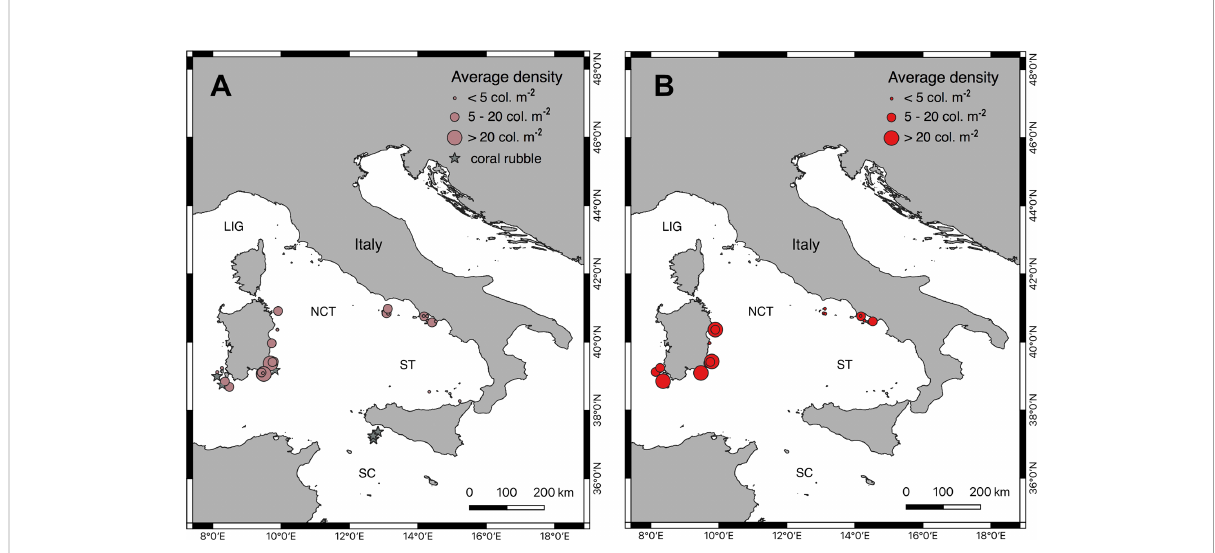
FIGURE 8 Deep mass mortalities. Comparative maps of the sites where dead (A) and living (B) colonies were observed. The size of the dots refers to the average density of the populations. Grey stars indicate the sites where patches of coral rubble were visible in the